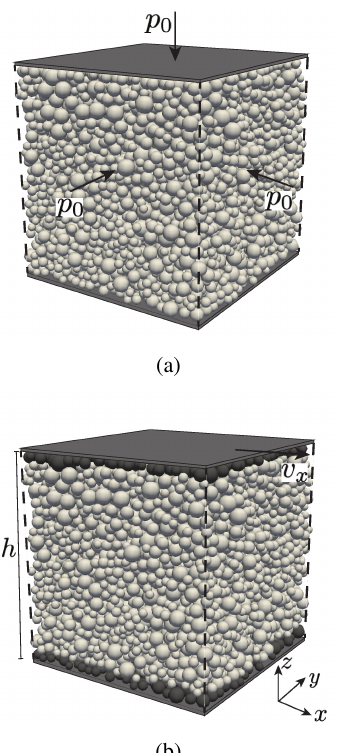
Figure 1: Particle arrangements and boundary conditions for a sample composed of 8000 particles: (a) at the end of sample preparation; (b) during constant height cyclic shearing. Gray particles are glued to the top and bottom walls of the bi-periodic cell.